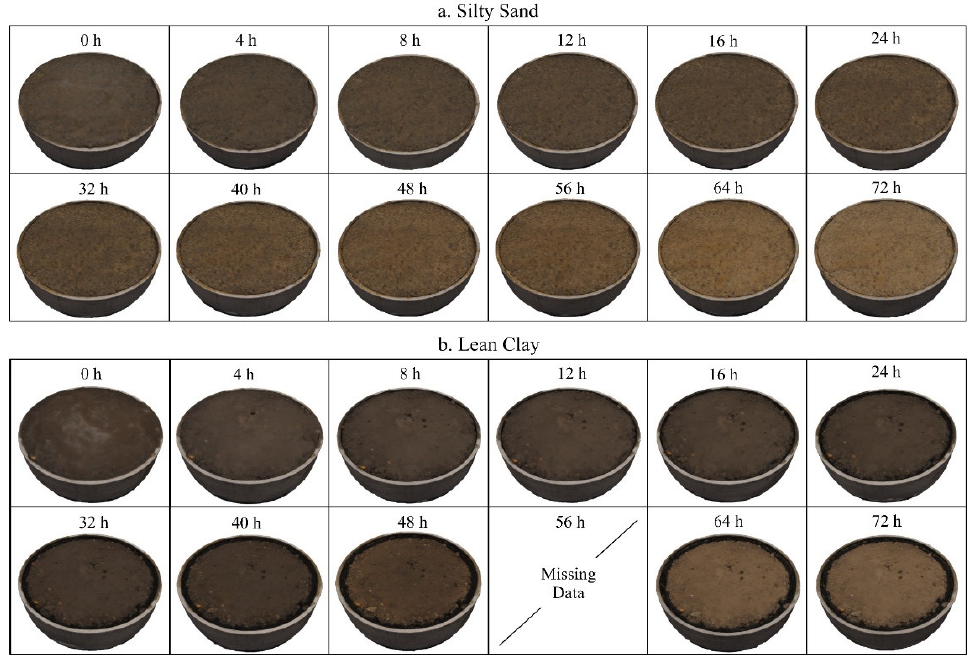
Figure 1. Three-dimensional models of the investigated soils during drying under ambient laboratory conditions: ( a ) silty sand; and ( b ) lean clay.